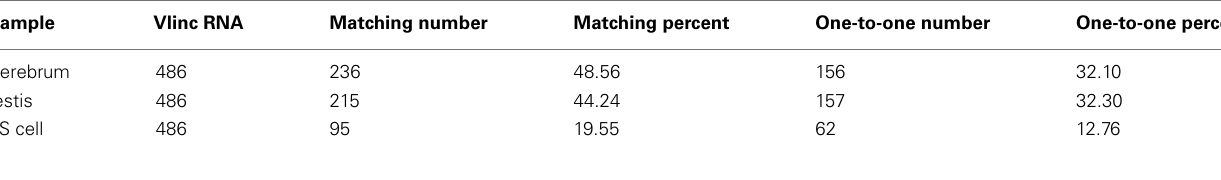
TableA6 |The evaluation ofTU building based on the vlinc RNA.